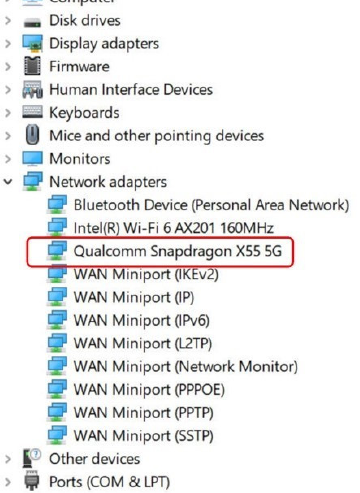
Figure 22. The 5G-dedicated antenna connection used in our experiments.